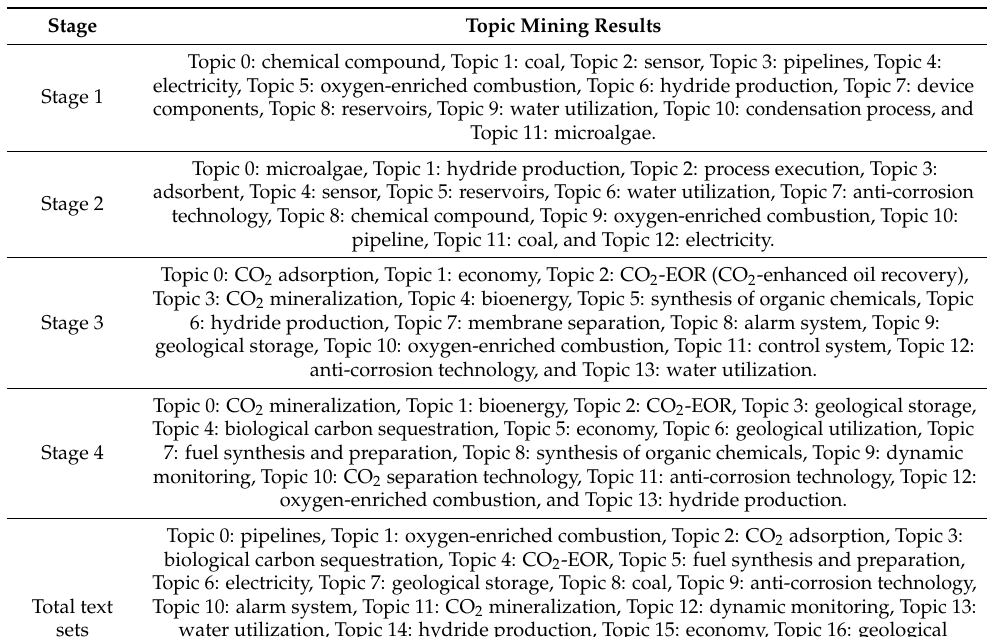
Table 3. CCUS technology topic mining results.